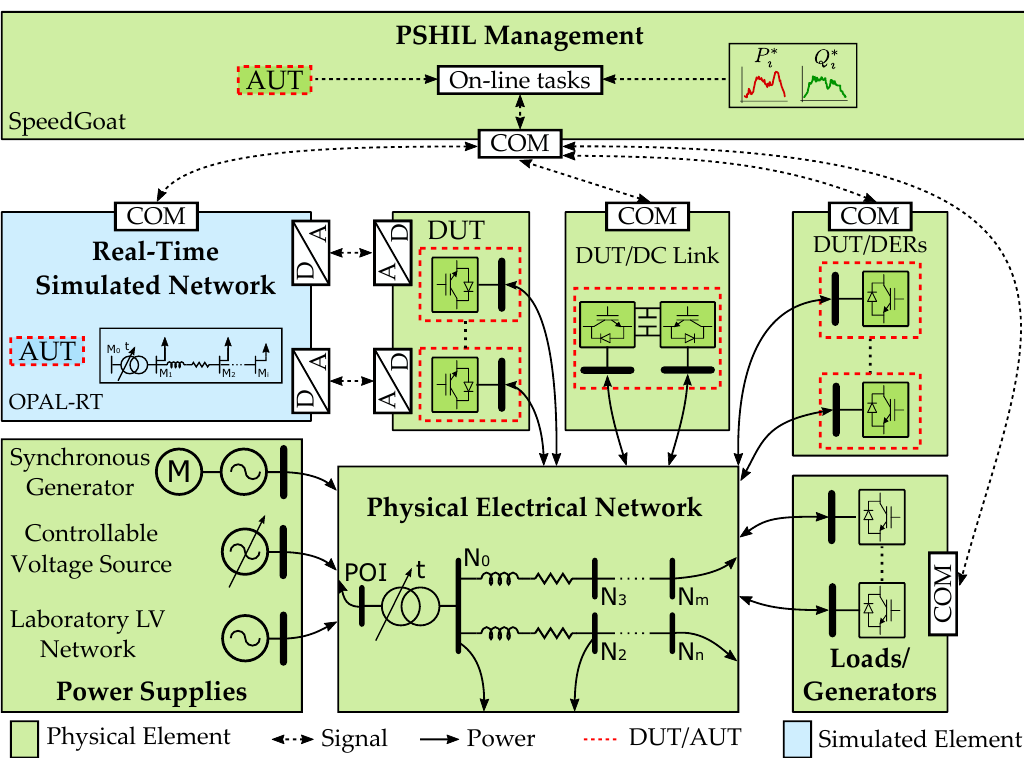
Figure 3. PSHIL platform of the Department of Electrical Engineering at the University of